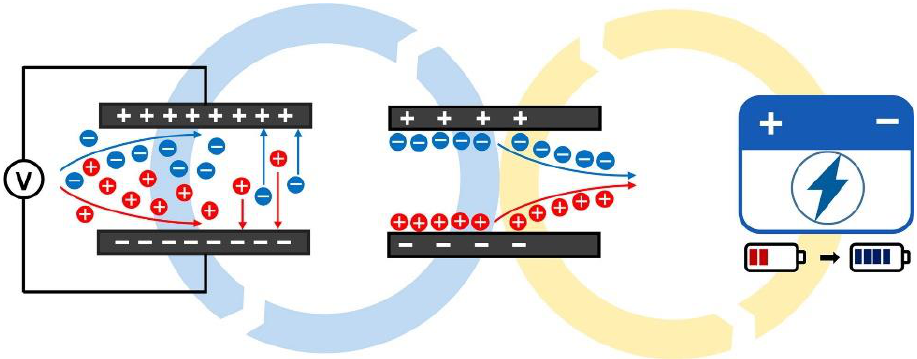
Figure 9. Schematic diagram of energy recovery system and charging based on our-switch buck- boost converter [156]. Copyright 2019, Elsevier. converter [156]. Copyright 2019,